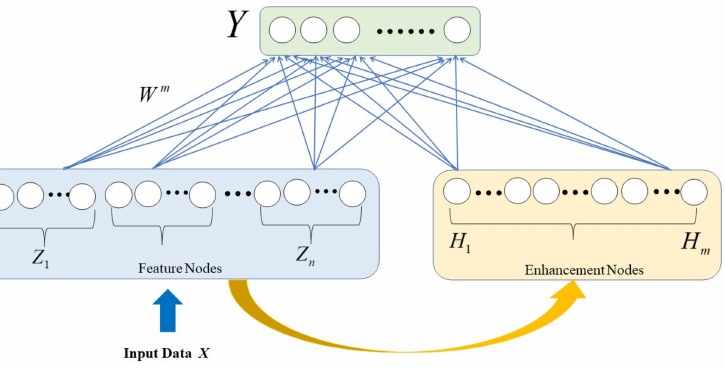
Figure 2. Framework of a typical